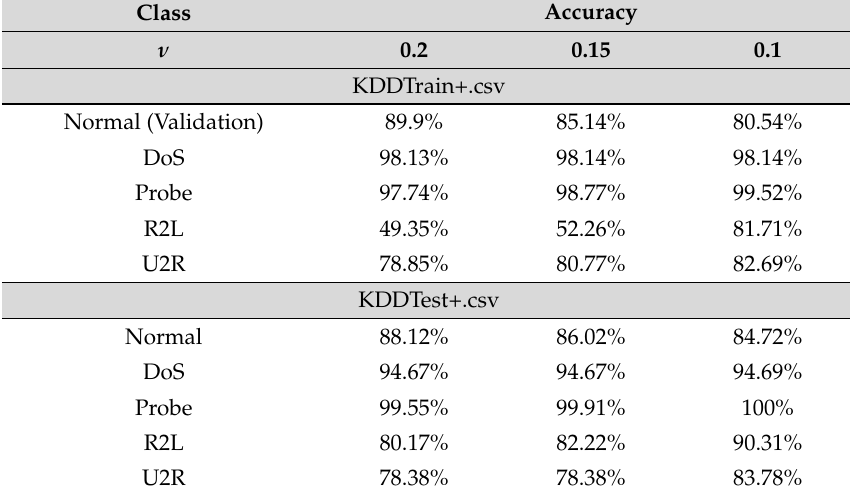
Table 5. NSL-KDD One-Class SVM